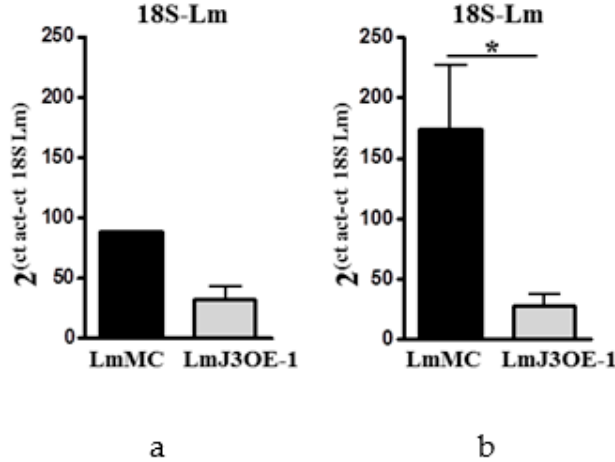
Figure 5. Parasite load levels in the mice footpads inoculated with LmjF.22.0810 -overexpressing and mock control parasites. Parasite burden was measured by Lm18S mRNA expression in the footpad lesions from both LmjF.22.0810 -overexpressing (LmJ3OE-1) L. major and the L. major control (LmMC) infected mice at day 23 ( a ) and 44 ( b ) post-inoculation. Bars represent the means (± SD) (* p < 0.05).